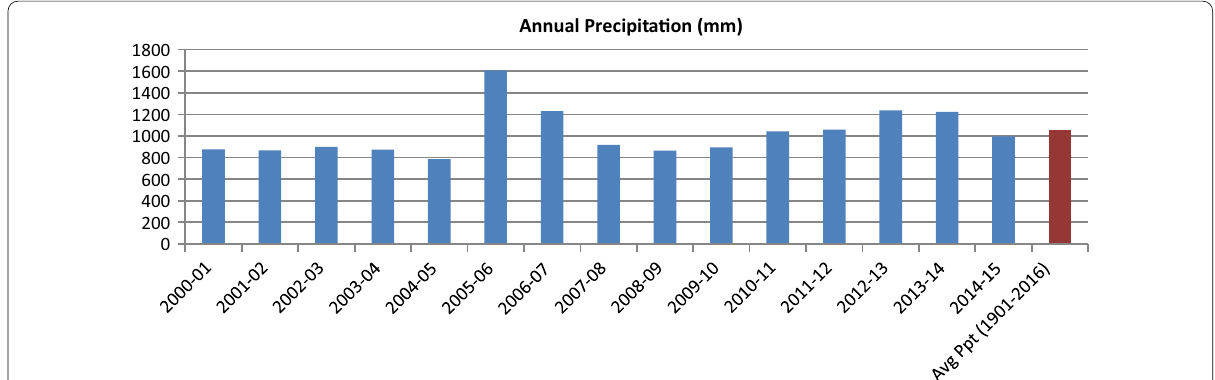
Fig. 25 Comparison of annual and average precipitation (mm) from 2000 to 2015 during the study